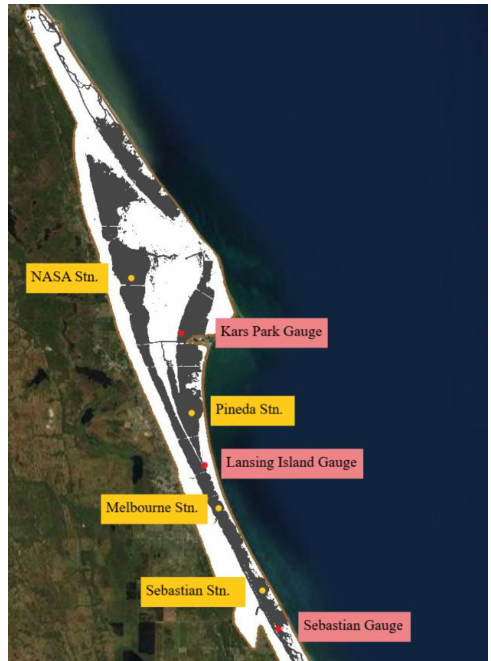
Figure 8. Locations for deployed pressure sensor gauges (red), and station locations for model timeseries output of wave parameters